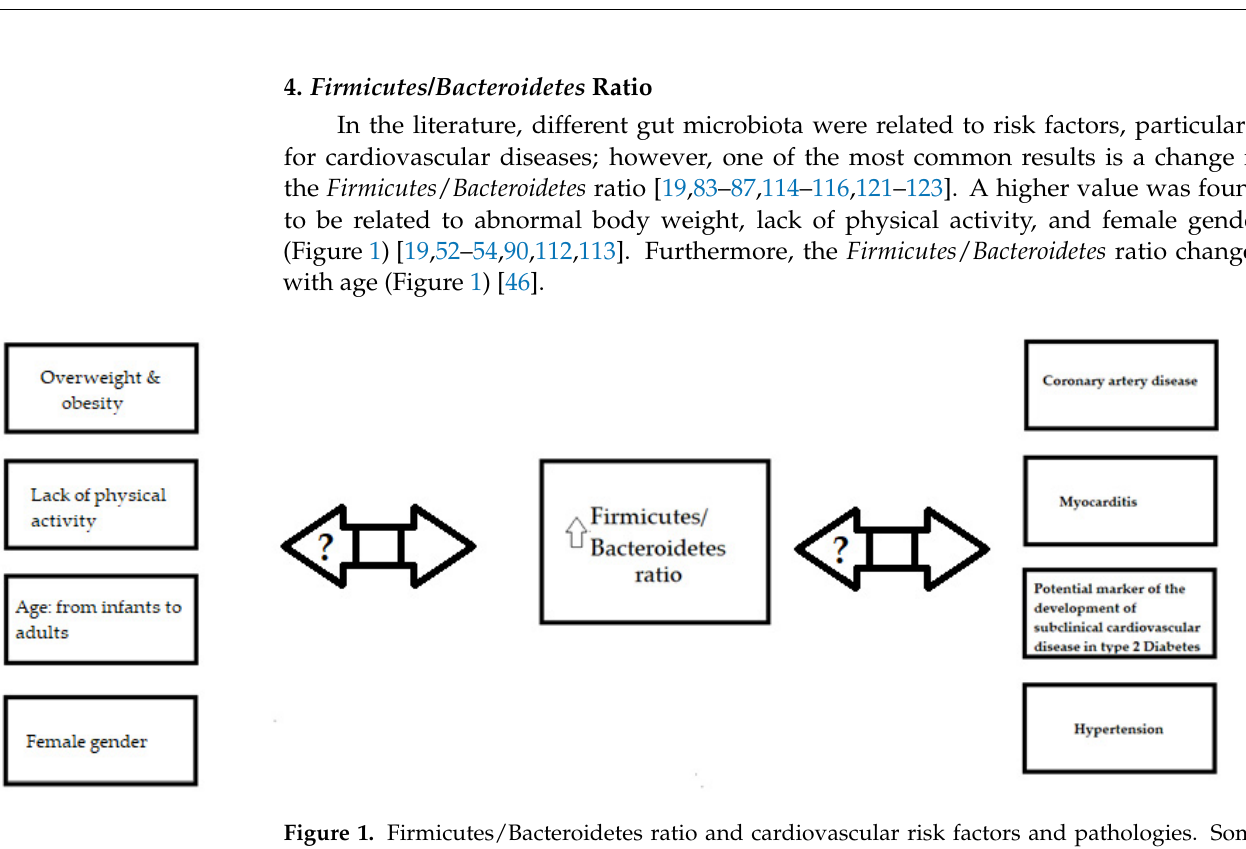
Figure 1. Firmicutes/Bacteroidetes ratio and cardiovascular risk factors and pathologies. Some cardiovascular risk factors influence Firmicutes/Bacteroidetes ratio, and Firmicutes/Bacteroidetes ratio might influence cardiovascular risk factors and cardiovascular pathologies. It is questionable whether a higher Firmicutes/Bacteroidetes ratio is a cause or a result of cardiovascular pathologies and if cardiovascular pathologies could affect Firmicutes/Bacteroidetes ratios.